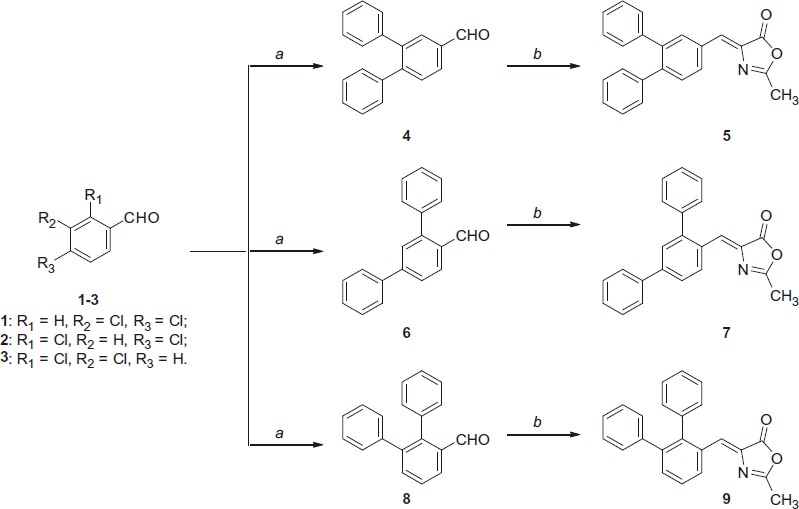
Reagents and conditions: (a) for compound 4: phenylboronic acid, Pd(OAc)2, K3PO4, TBAB, H2O, 125 °C; for compound 6: phenylboronic acid, Pd(OAc)2, PPh3, aq. 2 M Na2CO3, toluene, EtOH, 100 °C; for compound 8: phenylboronic acid, Pd(OAc)2, PPh3, aq. 2 M Na2CO3, toluene, EtOH, 100 °C, then phenylboronic acid, Pd2(dba)3, Cs2CO3, Cy3P 20% toluene, dioxane, 100 °C; (b) N-acetylglycine, Ac2O, CH3COONa, reflux.